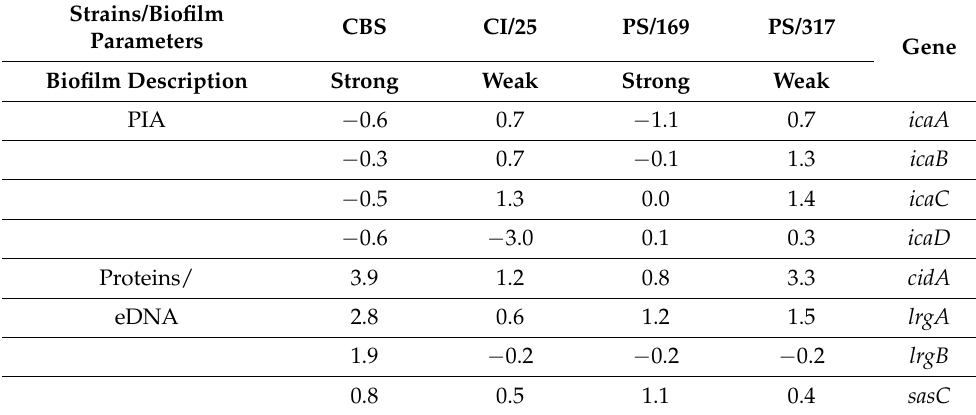
Table 1. Biofilm description and development mechanisms: RNAseq-based differential expression (Log2 fold change) in PCs vs TSB of genes associated to different biofilm mechanisms in tested S. aureus isolates (CBS2016-05 = CBS; CI/BAC/25/13/W = CI/25; PS/BAC/169/17/W = PS/169; PS/BAC/317/16/W =